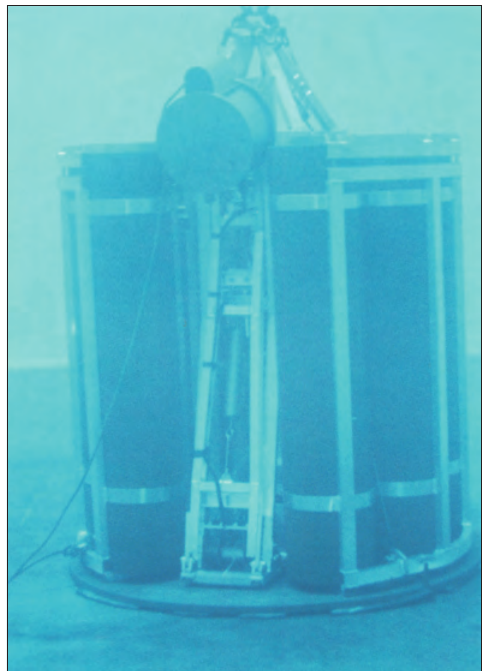
Fig. 1. The Pascal&Person three components ocean bottom seismometer. The syntactic foam provides buoyancy. A lever arm deploys the cylindrical seis- mometer array from the main